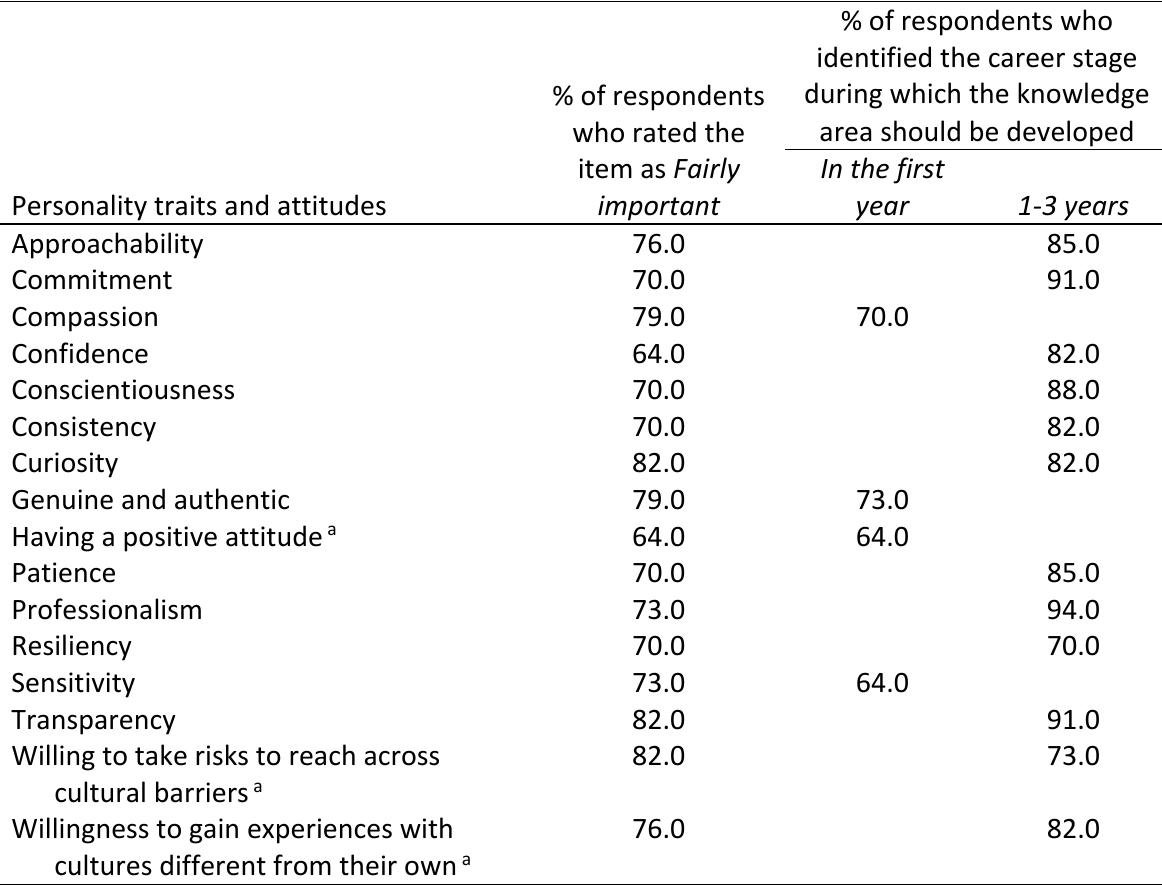
Personality Traits and Attitudes Rated as Fairly Important by Career Stage